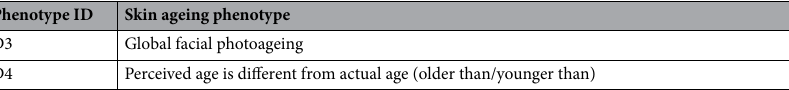
Table 2. The 56 skin ageing phenotypes. Varying terminology used by different studies for identical phenotypes are separated by a slash